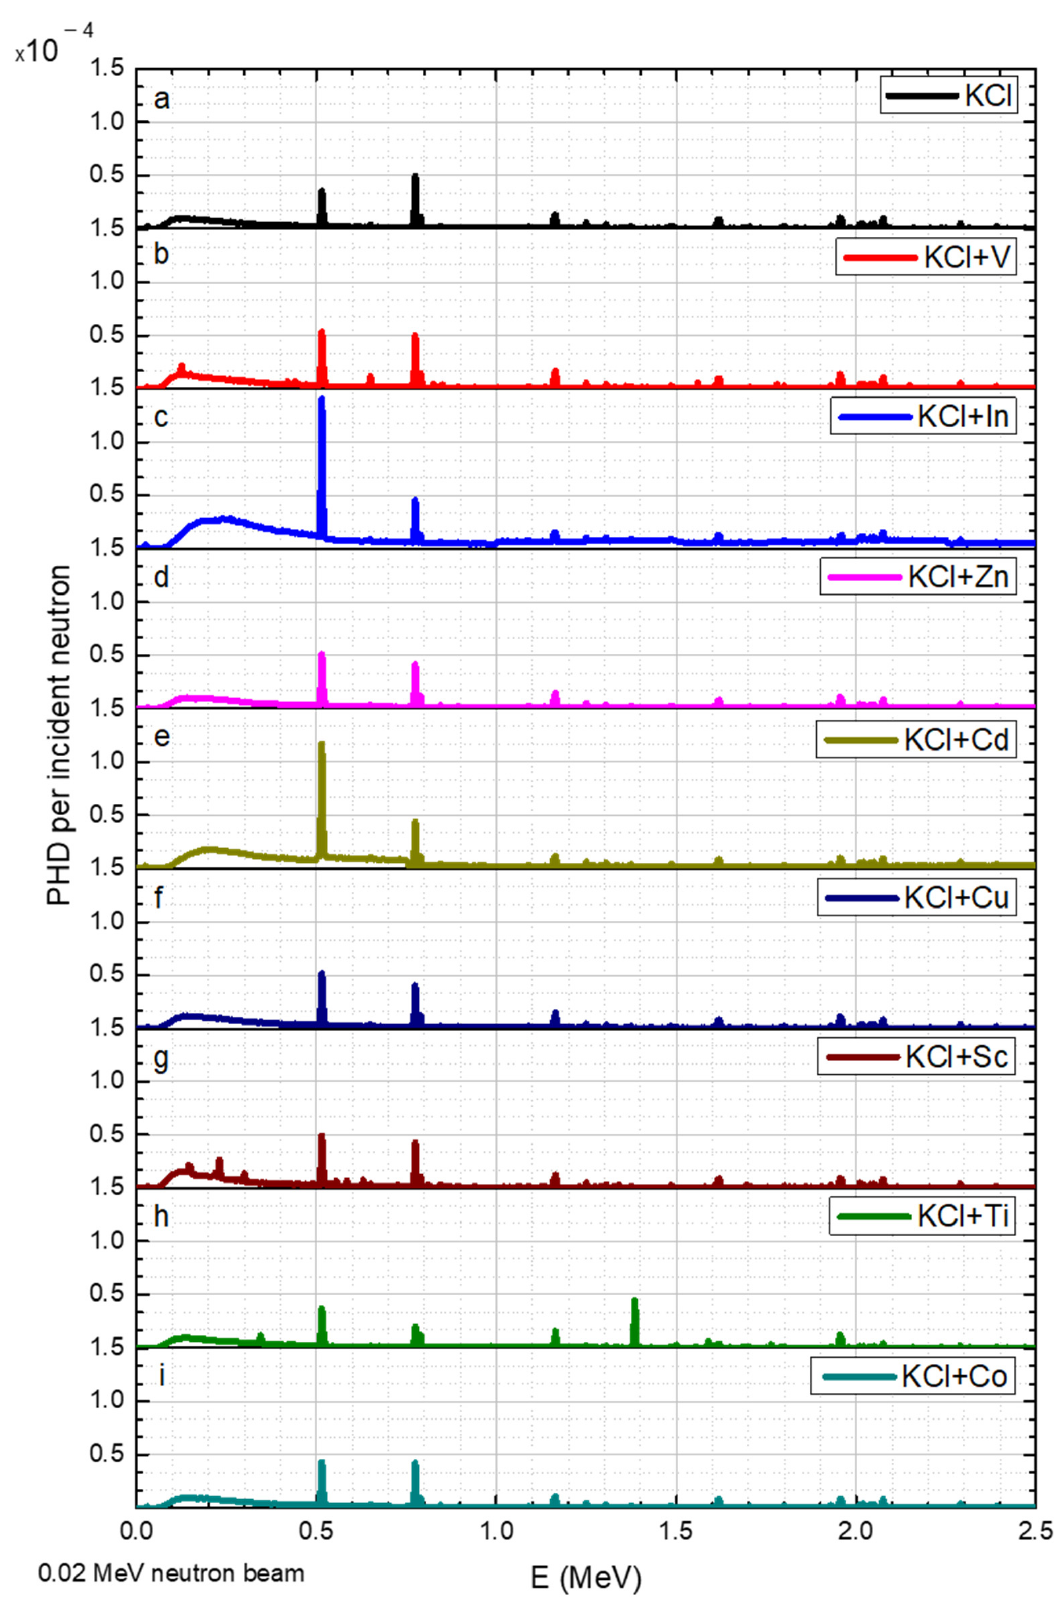
Figure 4. PGNA results for 0.02 MeV neutron energy, where the y axis is the gamma pulse height distribution (PHD) per incident neutron obtained in the detector and the x axis is the gamma radiation energy. The data corresponds to a range of elements ( a – i ) added to the KCl.